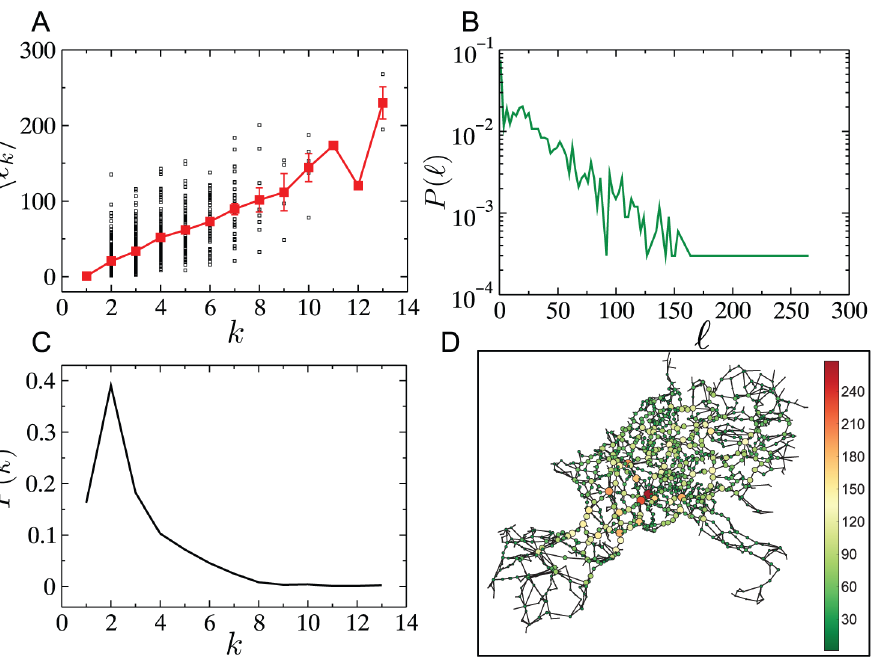
Figure 11. Characteristics of the UCTE network. The network consists of N ~ 1254 nodes with an average degree of S k T ~ 2 : 89 . (A) Scatter of loads as a function of node degree k (black squares) and the average load (red squares) as a function of node degree k . (B) The load distribution on the intact UCTE network. (C) The degree distribution of the UCTE network. (D) A visualization of the UCTE network with loads indicated using both node size and color.